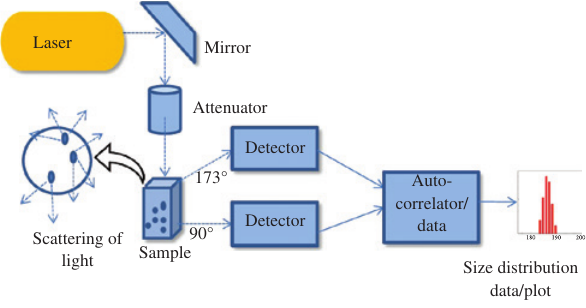
Figure 1: Representative flow diagram of a DLS